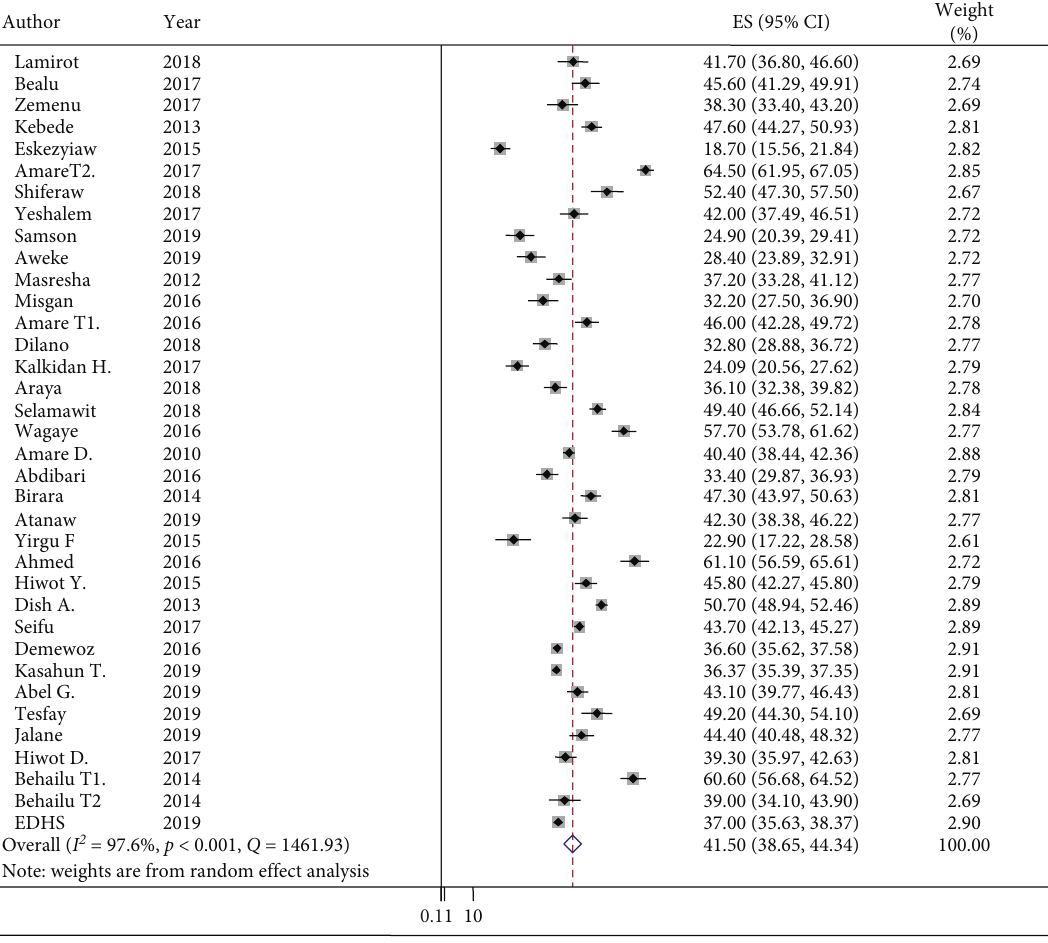
Figure 2: The prevalence of stunting among children under five years of age and its 95% CI in Ethiopia,